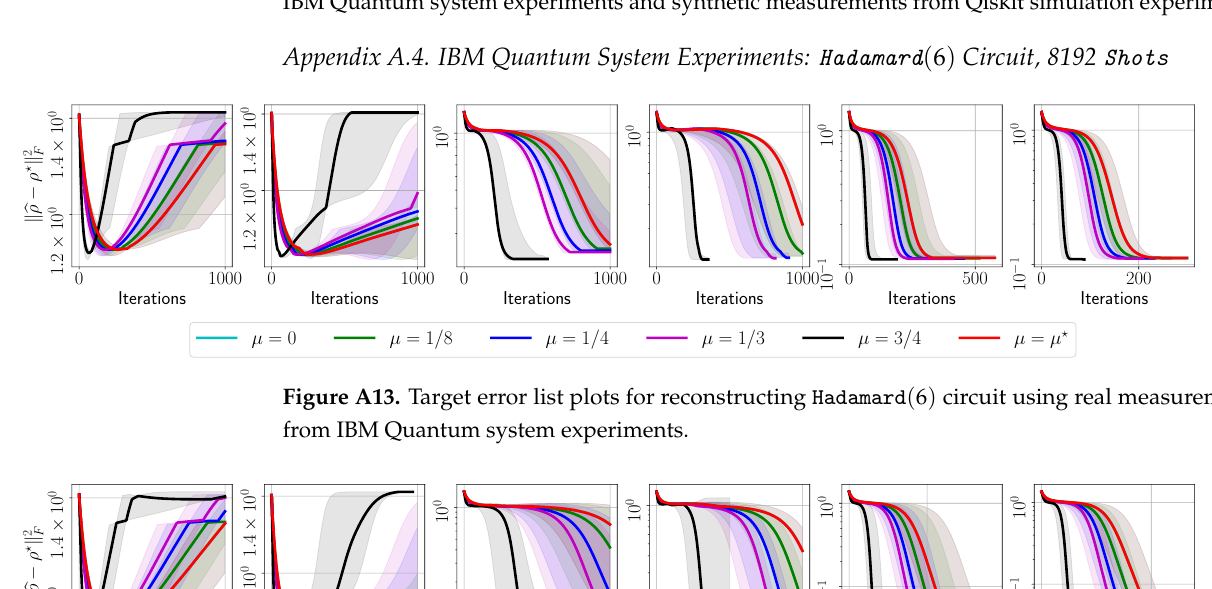
( 8 ) circuit using using real measurements from −